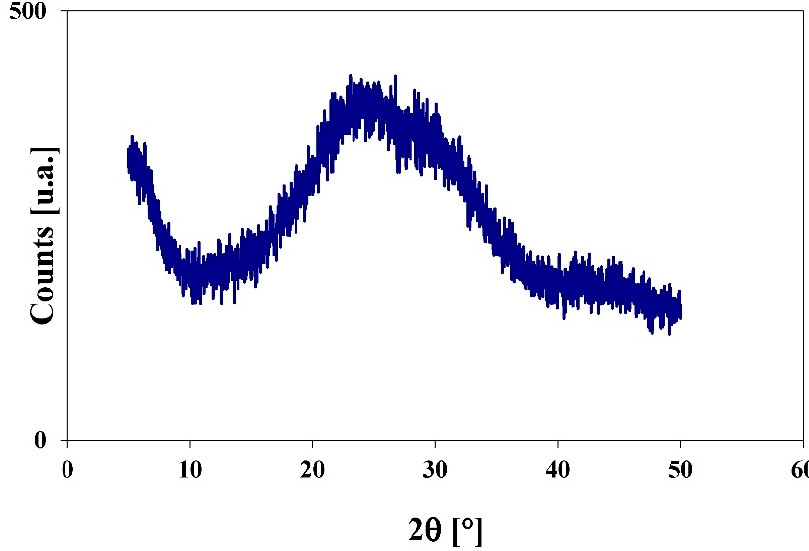
Figure 1. XRD analysis of the Glass powder (GP) used in this study.